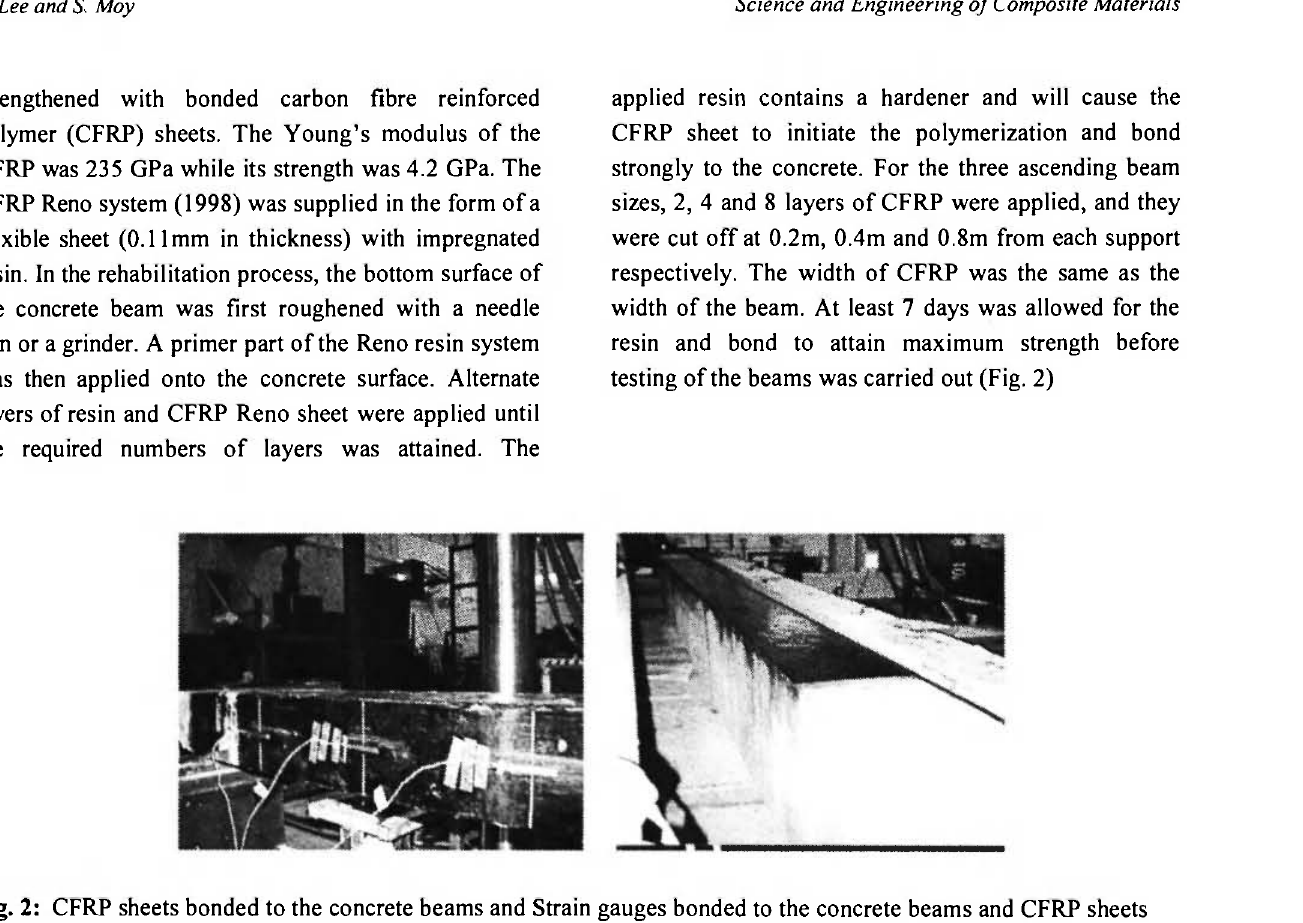
Fig. 2: CFRP sheets bonded to the concrete beams and Strain gauges bonded to the concrete beams and CFRP